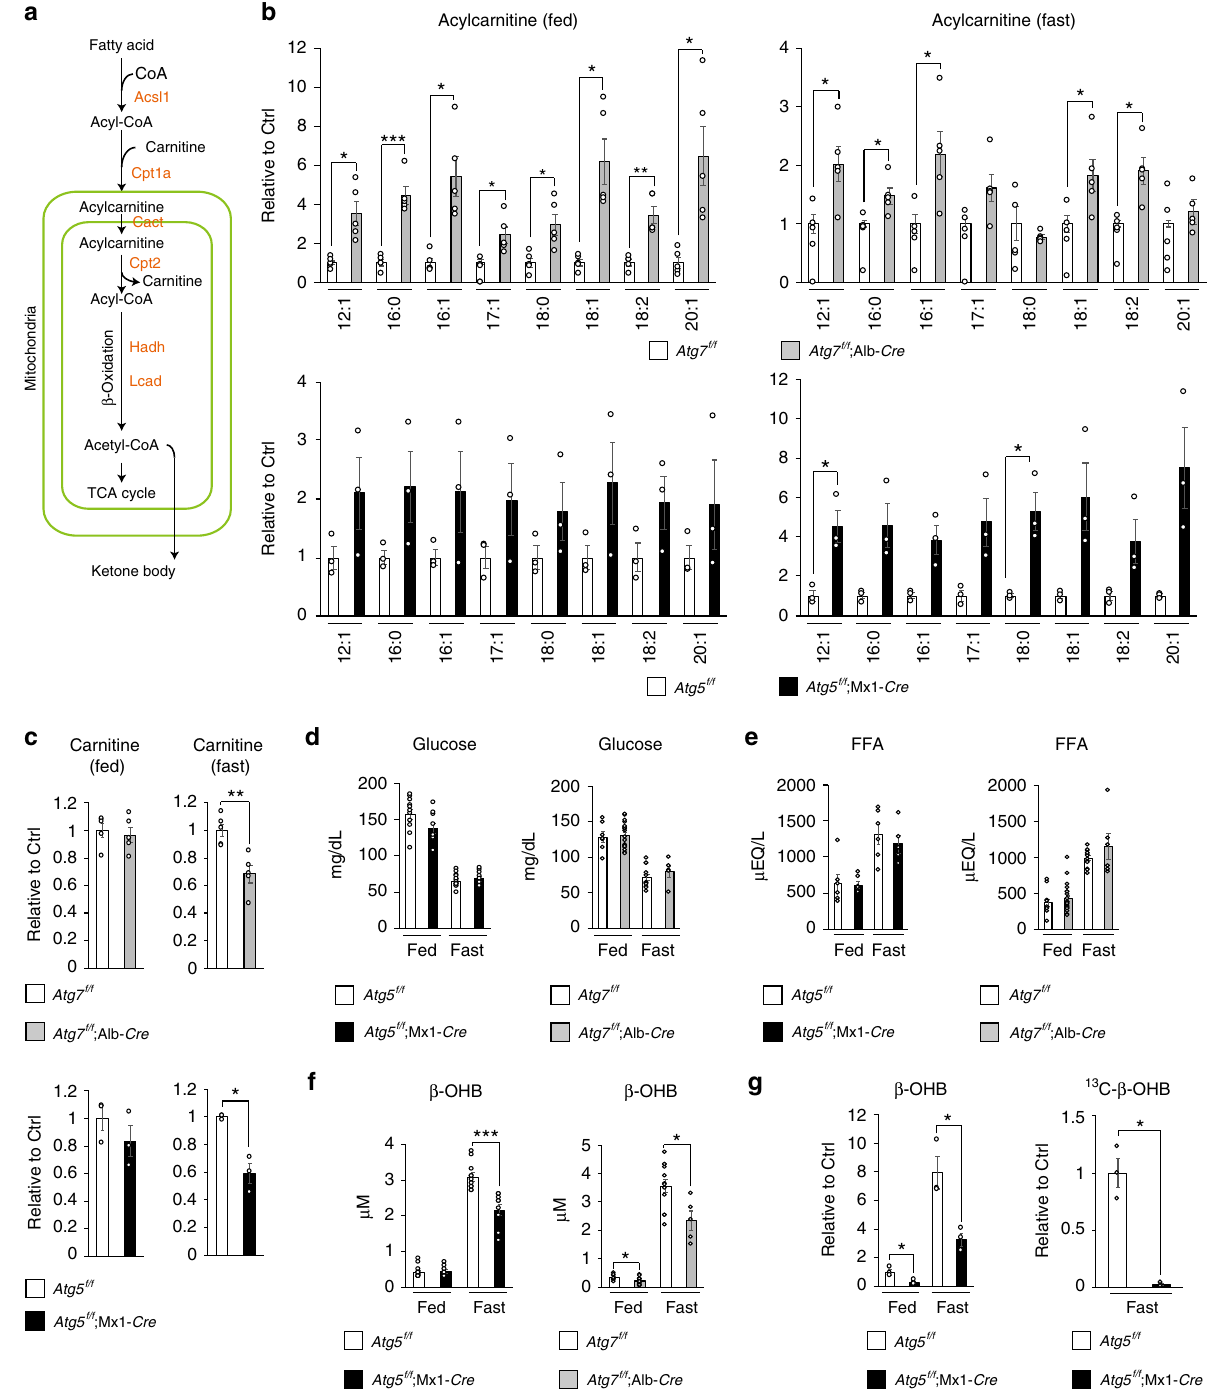
Fig. 1 Decreased lipid-oxidation in autophagy-de fi cient livers. a Enzymes involved in lipid catabolism, and representative metabolites produced by the enzymes. b Levels of acylcarnitines in livers of 5-week-old Atg7 f/f ;Alb- Cre ( n = 5) as well as of 12-week-old Atg5 f/f ;Mx1- Cre ( n = 3) mice, relative to